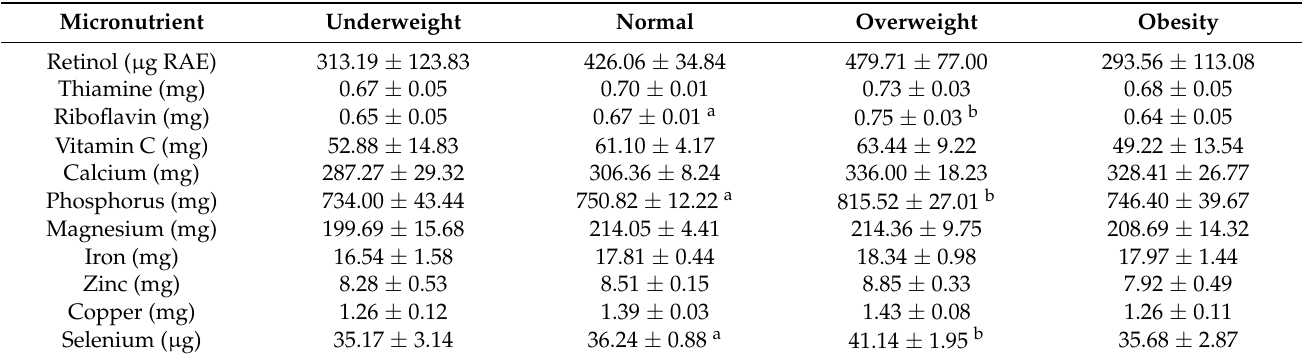
Table 3. Estimated daily micronutrient intakes from foods by category of body weight girls aged 6–17 years, CHNS 2015 ( n = 749) 1 .